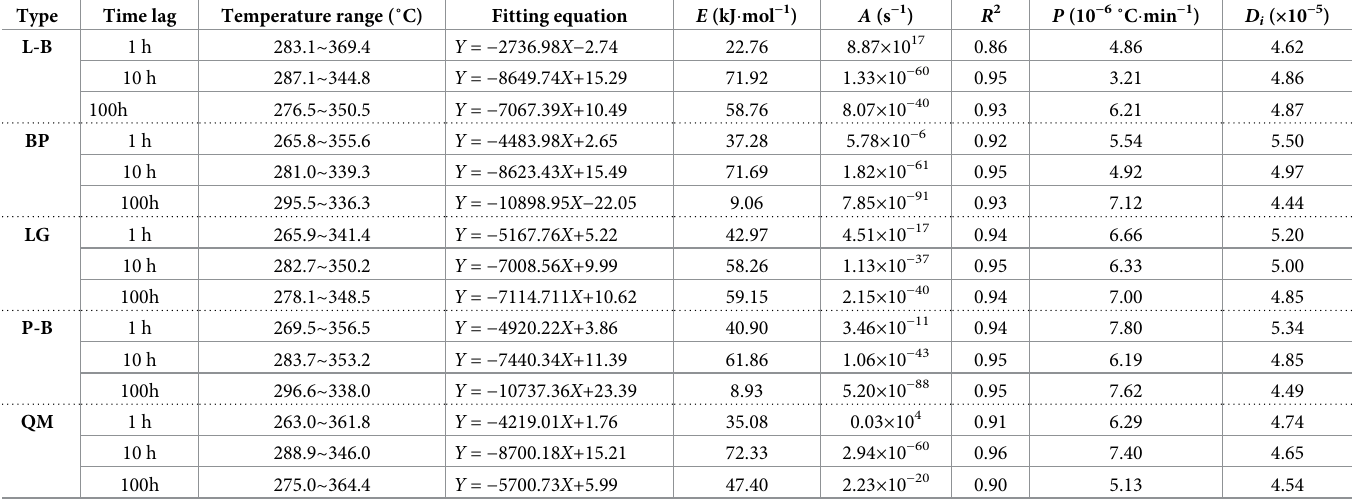
Table 6. Pyrolysis parameters and pyrolysis characteristic indices of fuel samples with different time